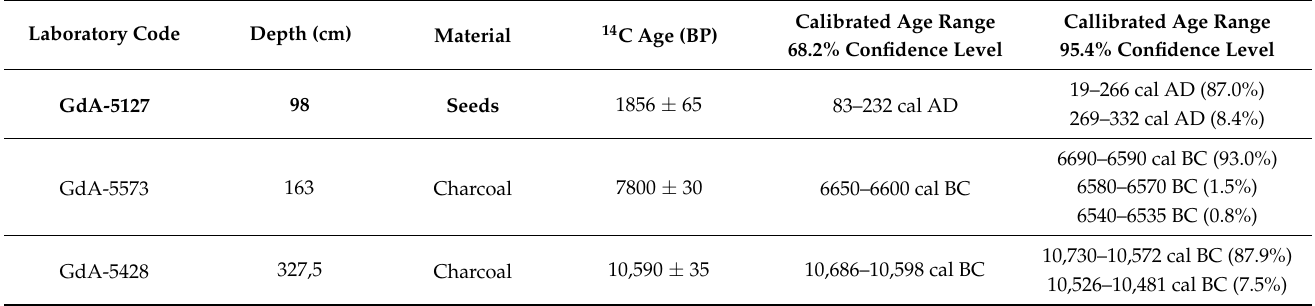
Table 2. Results of radiocarbon AMS dating of charcoals and seeds from the Blatuša mire (prepared by: N. Piotrowska; modified by: D. Hruševar).